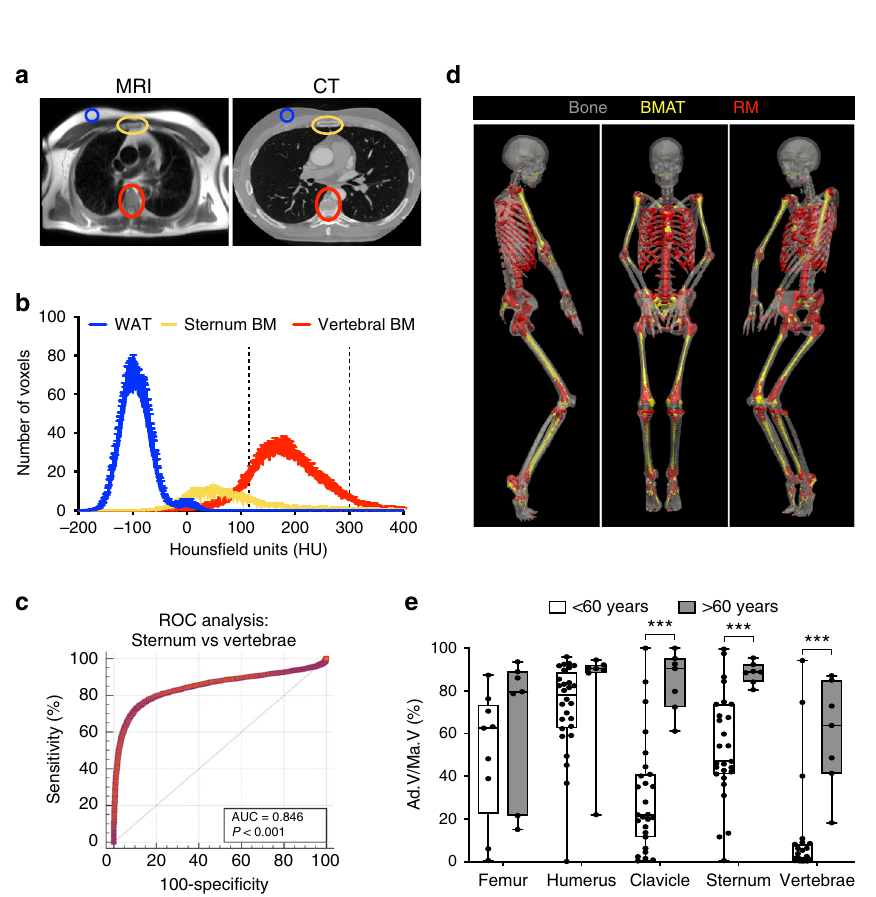
Fig. 6 CT-based identi fi cation of BMAT in humans. a Representative MRI (HASTE) and CT images from one subject. b HU distribution of scWAT, BMAT- rich BM (sternum) and BMAT-de fi cient BM (vertebrae). Data are mean ± SEM ( n = 33). Thresholds diagnostic for BMAT (<115) and RM (115 – 300) are indicated by dashed lines. c ROC analysis to identify HU thresholds to distinguish BMAT-rich (sternum) from BMAT-de fi cient (vertebrae) regions of BM. d CT images of a 32-year-old subject, highlighting BMAT or RM identi fi ed using the diagnostic thresholds in ( b ); tibiae are shown for completeness